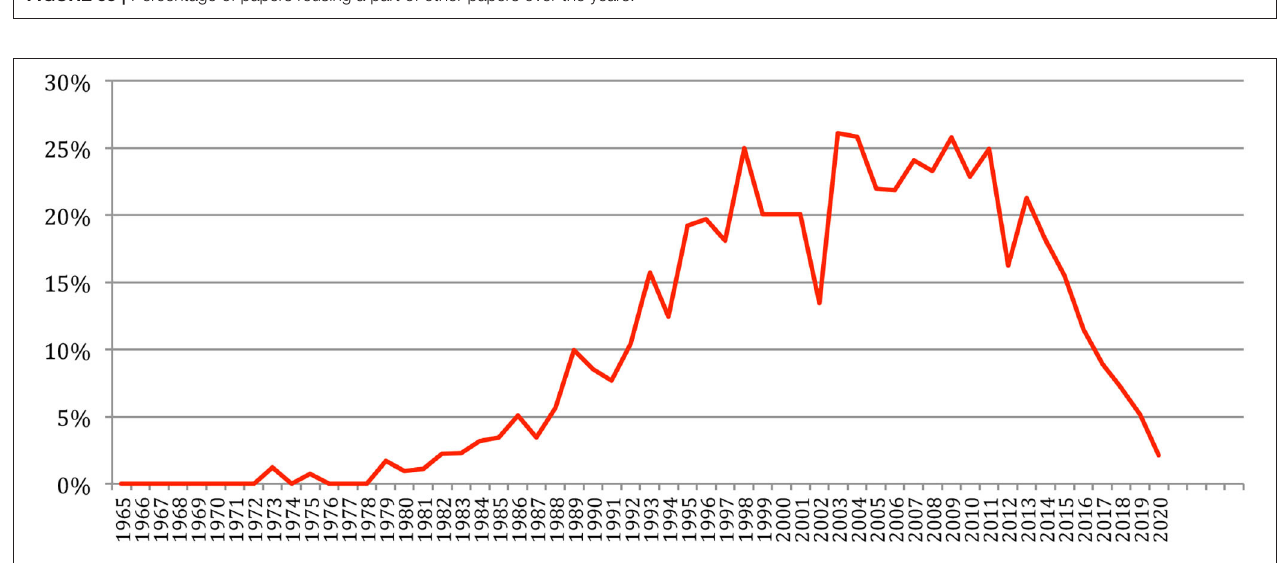
FIGURE 53 | Percentage of papers reusing a part of other papers over the years.